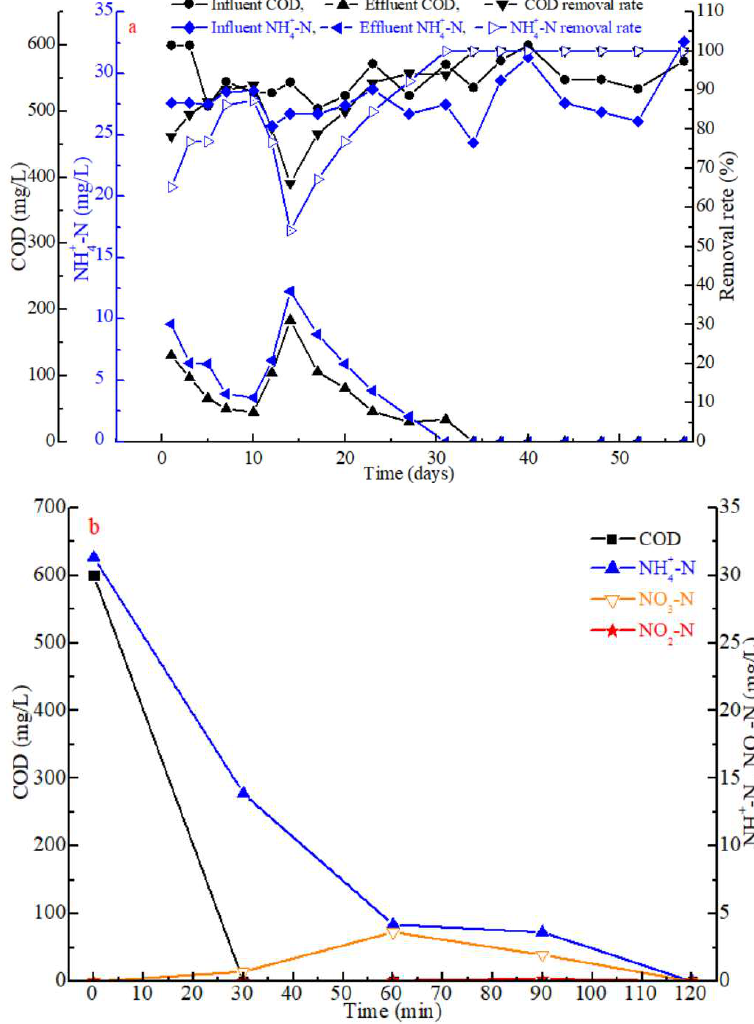
Figure 5. Reactor performance profile during ( a ) the entire rapid granulation process and ( b ) during a single day after the stabilization of the granulation process on day 40.